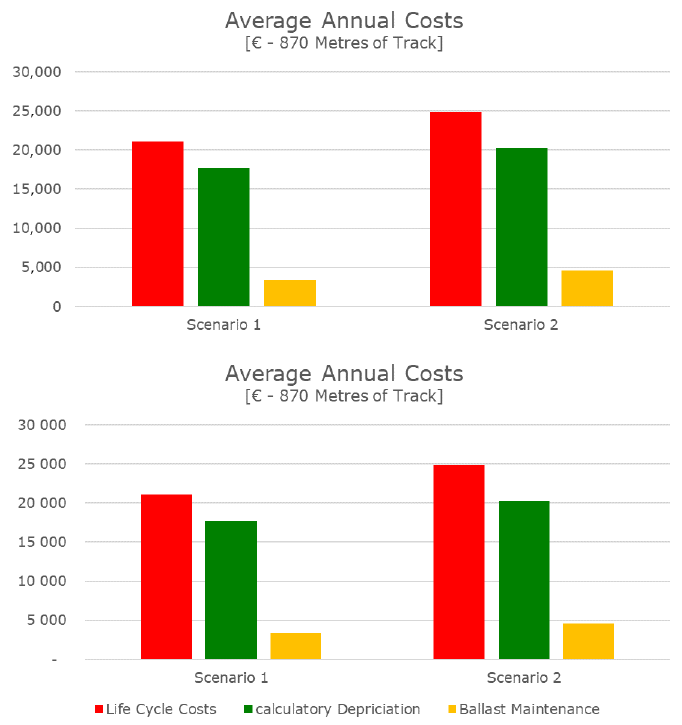
Figure 9. Depicting Life Cycle Costs in the form of average annual Costs for the two Scenarios and thus the long term economic Impact of reduced Track Tamping.